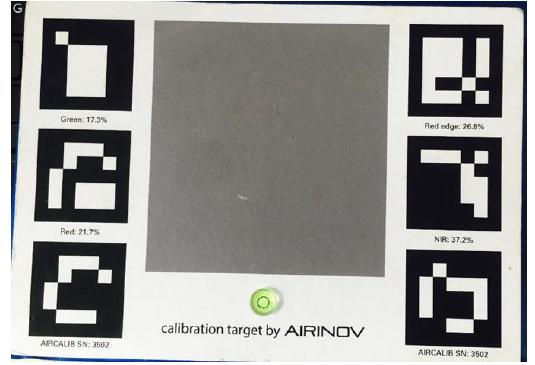
Figure 4. The balance card used for radiometric